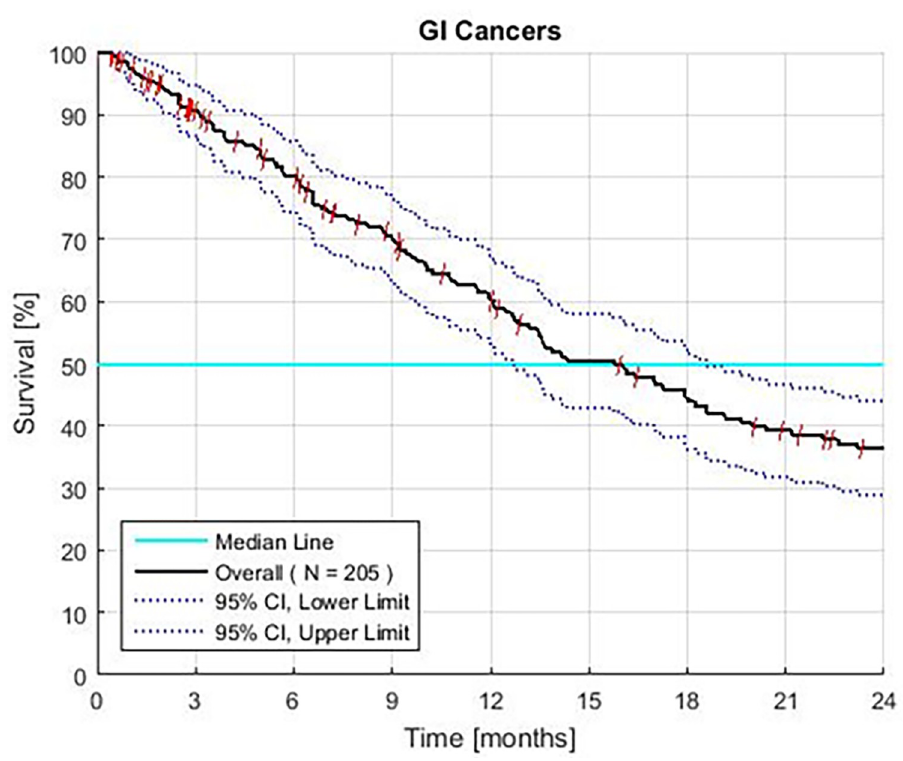
Fig 2. Survival of all patients with advanced gastrointestinal (GI) cancer treated with GFLIO. Third line colon, and both pancreatic, and intrahepatic bile duct tumors, with resistant and without prior